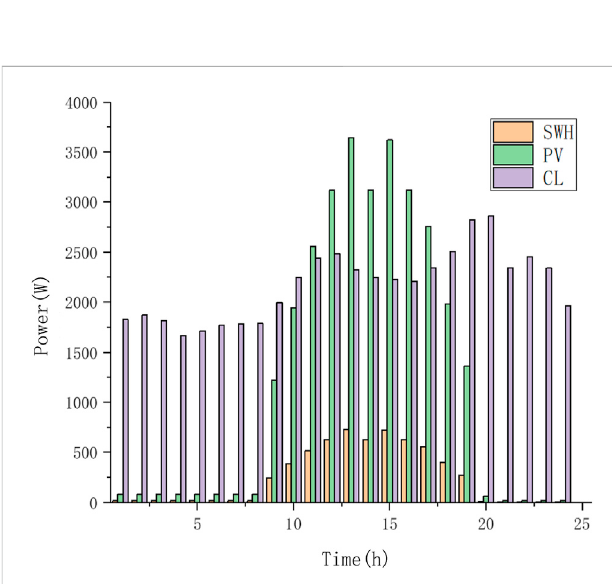
FIGURE 4 The prediction of the SHW system, the RPV system (PV), and CL in the DA stages.